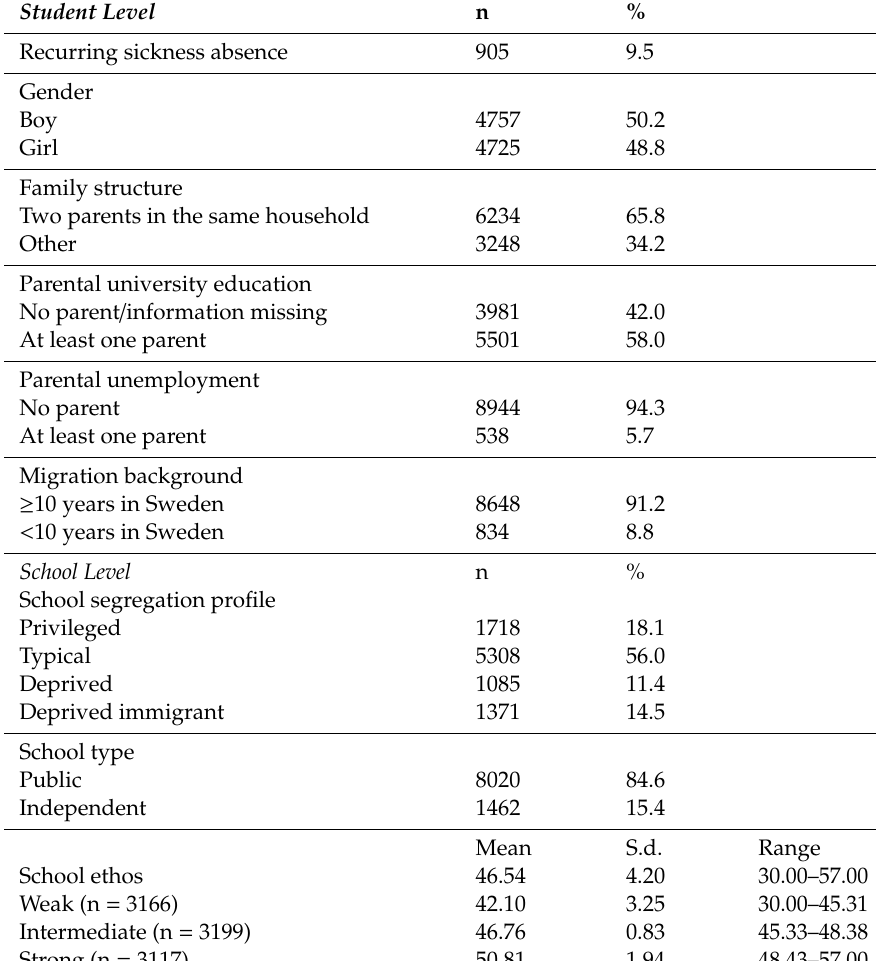
Table 1. Descriptive statistics of variables included in the analyses. N = 9482.